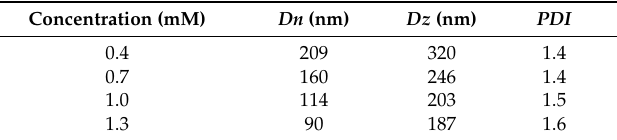
Figure 1. Distribution of particle size of chitosan ‐ AuNPs at the different concentrations of HAuCl 4 ∙ 3H 2 O used in the synthesis: ( Δ ) 0.4, ( □ ) 0.7, ( ○ ) 1.0 and ( ∇ ) 1.3 mM. Table 1. Average particle sizes, Dn , Dz and PDI of chitosan ‐ AuNPs calculated from the distribution data of Figure 1, for each concentration of HAuCl 4 ∙ 3H 2 O.